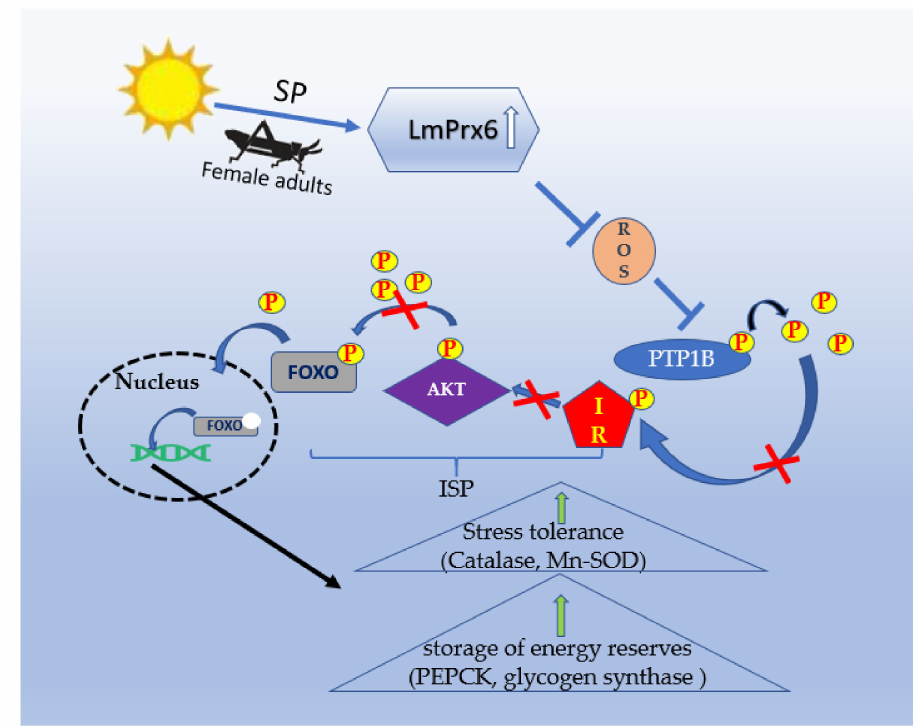
Figure 1. The hypothetical molecular relationships of LmPrx6 (Prx6 of Locust migratoria ) in ISP in an adult female: Female adults sense the short photoperiod (SP) and cause enhanced LmPrx6 that inhibits ROS. The reduction of ROS leads to the phosphorylation of PTP1B. The phosphorylated LmPTP1B inhibits IR, which could phosphorylate AKT. The attenuation of AKT leads to the dephosphorylation of FOXO. Then, the dephosphorylated FOXO transfers to the nucleus to induce the expression of genes of stress tolerance (catalase and Mn-SOD) and genes of storage of energy reserves (phosphoenolpyruvate carboxy kinase (PEPCK) and glycogen